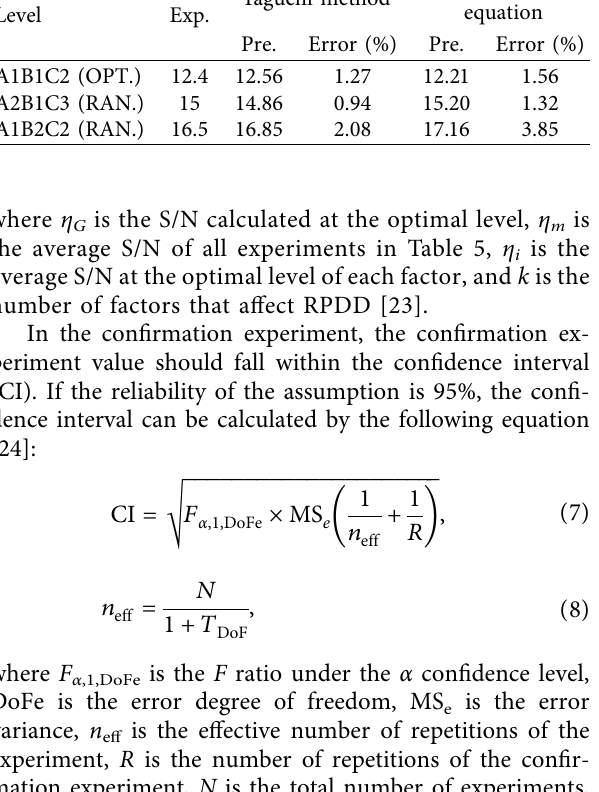
Table 8: Predicted values and confirmation experiment results by Taguchi method and regression equations. Prediction Taguchi method equation Level Exp. Pre. Error (%) Pre. Error (%) A1B1C2 (OPT.) 12.4 A2B1C3